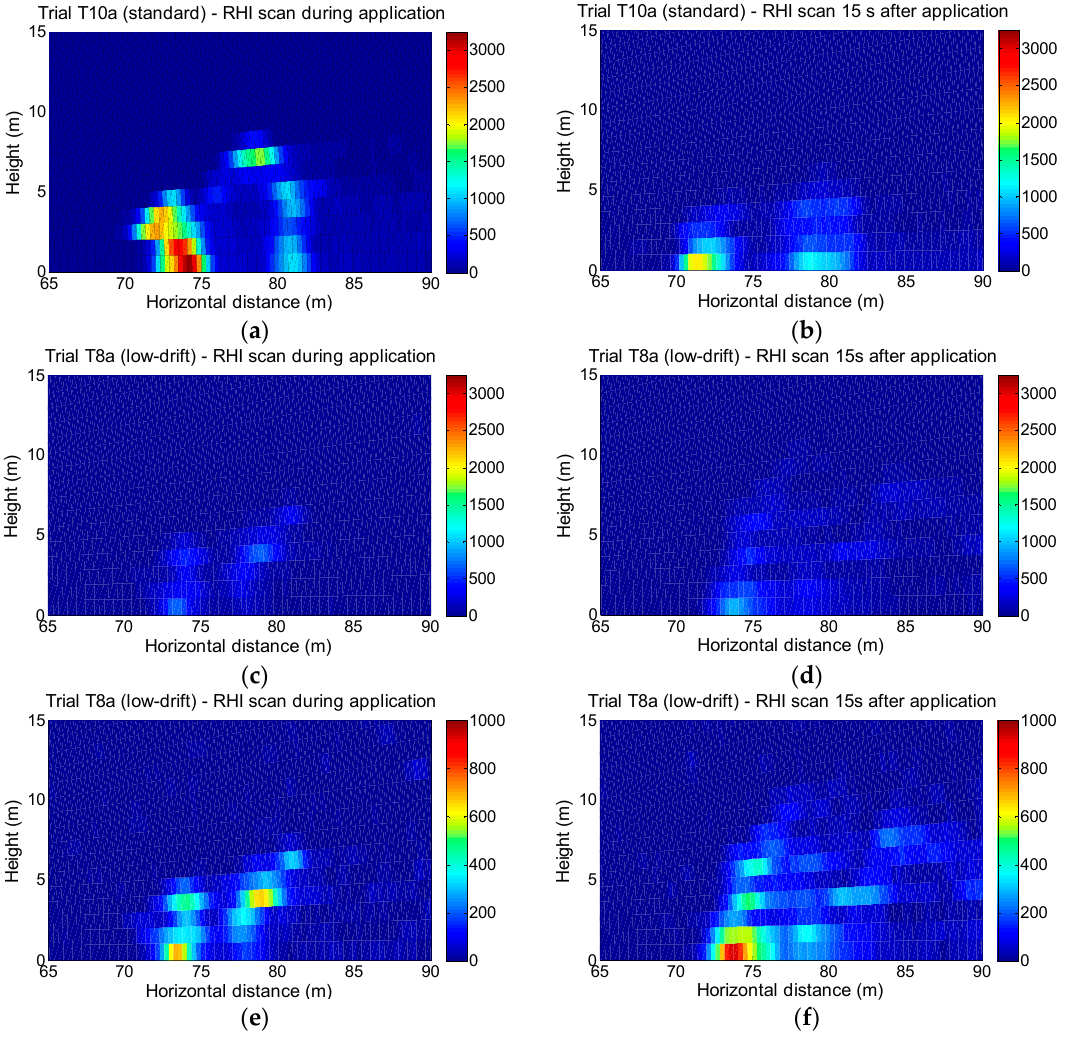
Figure 7. RHI (vertical) lidar scans of several spray plumes. ( a ) Test T10a (standard nozzles), during the application; ( b ) Test T10a, 15 s after the application; ( c ) Test T8a (low-drift nozzles), during the application; ( d ) Test T8a, 15 s after the application; ( e ) Test T8a, during the application; ( f ) Test T8a, 15 s after the application. Colorbar represents range-corrected backscattered signal (arbitrary units: a.u.). Signal range in ( a – d ) is 0–3250 a.u.; in ( e , f ) is 0–1000 a.u.